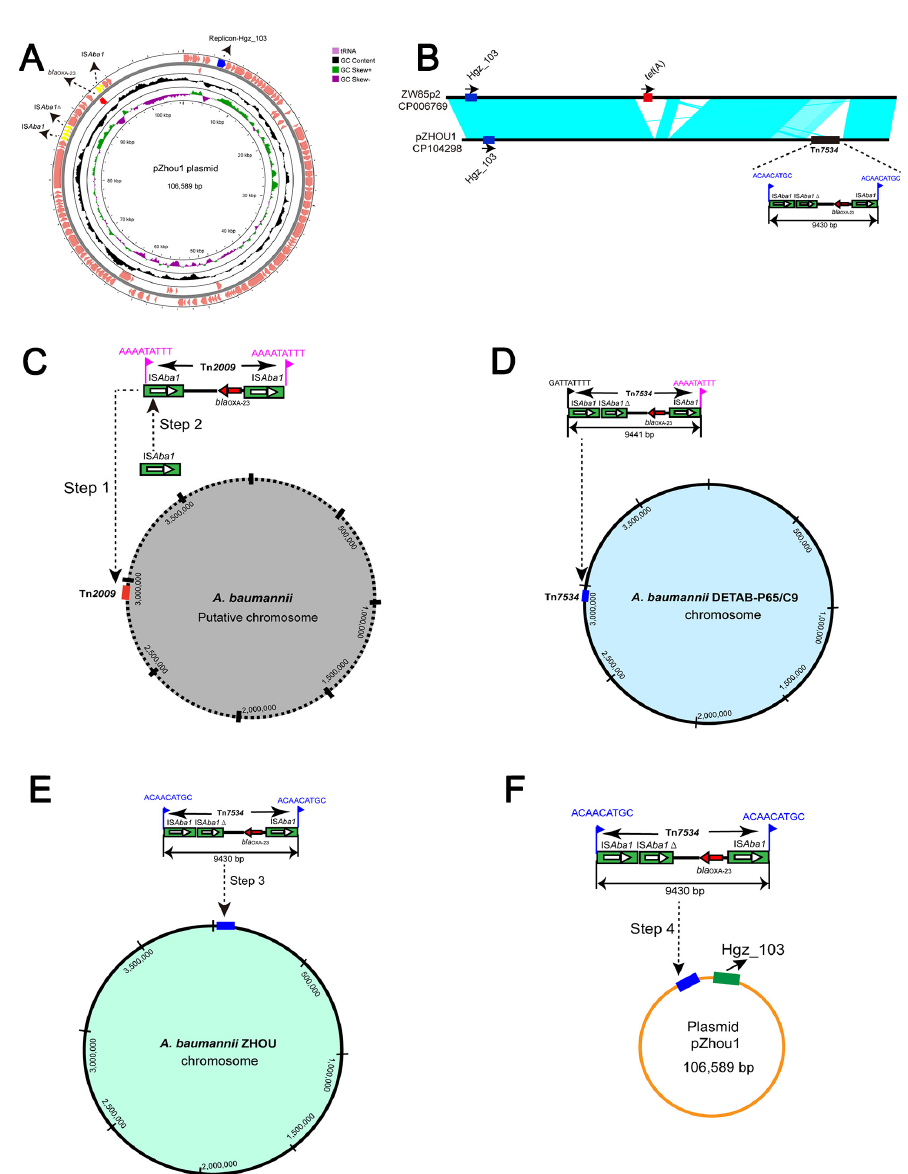
Figure 2. Circular map of Hgz-103-type plasmid pZhou1 and comparison with ZW85p2 and the proposed diagram for the evolution of ST46 Pas CRAB. ( A ) Circular map of Hgz-103-type pZhou1 plasmid. Arrows show the direction of ORFs. Red arrow indicates the bla OXA-23 gene. Blue arrow indicates the Hgz-103 replicon. Yellow arrows represent IS Aba1 . ( B ) Linear maps and comparison with the ZW85p2 plasmid (accession number: CP006769). Blue arrows indicate the Hgz-103 replicons, with black arrows indicating the direction of ORFs. Red box indicates the resistance gene tet (A). The Tn 7534 transposon is shown and labeled with a 9 bp TSD (ACAACATGC). Homologous segments (representing ≥ 99% identity) are indicated by light blue shading. ( C ) The putative ST46 Pas chromo- some circle map. Tn 2009 transposon is indicated by a red box with a 9 bp TSD (AAAATATTT). The bla OXA-23 gene is shown by the red arrow. IS Aba1 is indicated by a green box with a white arrow. The complete Tn 2009 composite transposon was integrated into the putative A. baumannii chromosome, followed by another copy of IS Aba1 , which interrupted the original IS Aba1 , contributing to generating IS Aba1 ∆ to form transposon Tn 7534 in A. baumannii DETAB-C9 or DETAB-P65, as shown in ( D ). and pZHOU1 plasmid. The 9 bp TSDs (ACAACATGC) are indicated by blue